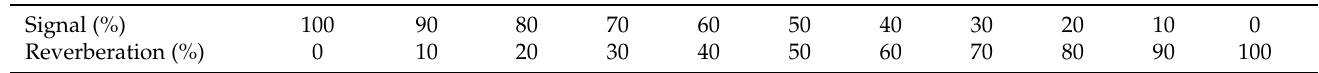
Table 1. The different Signal-to-Reverberation Ratios that were used for the model